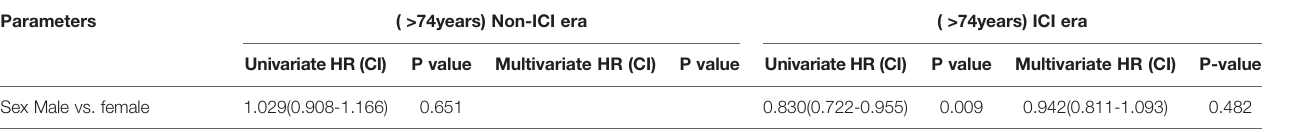
TABLE 3 C. | Univariate and multivariate analysis of factors affecting the survival in non-ICI era and ICI in third age group.